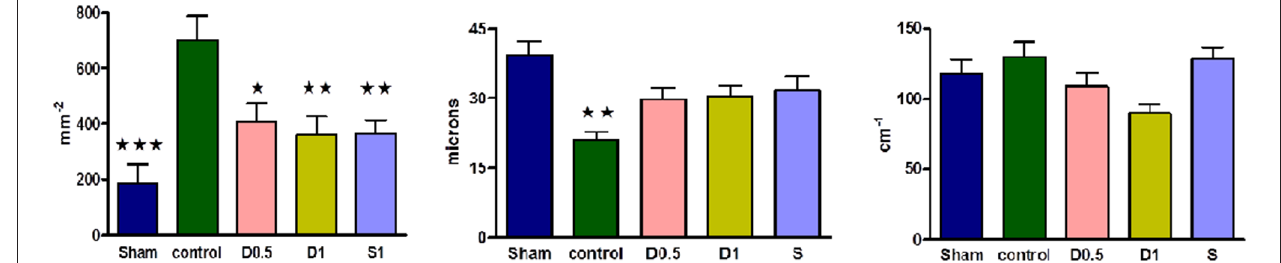
FIGURE 2 | (Left) Numbers of adherent leucocytes per square mm of endothelium in ileal post-capillary venules at 2.5h of laparotomy and endotoxemia ( n = 6 all groups). Numbers of vessels observed per group ranged from 8 to 18. Sham, dopexamine, and salbutamol treated groups demonstrated significantly less adhesion than controls. Data presented as mean (SEM). One-way ANOVA (Bonferroni’s post-tests, * p < 0.05, ** p < 0.01, *** p < 0.001 vs. controls). (Mid) Intestinal arteriolar diameters of the ileum at 2.5h of laparotomy and endotoxemia ( n = 6 all groups). Numbers of vessels measured per group ranged from 8 to 19. When compared to shams and unlike controls, ileal arteriolar diameters were not significantly reduced in dopexamine and salbutamol treated groups. Data presented as mean (SEM). One-way ANOVA (Bonferroni’s post-tests, ** p < 0.01 vs. shams). (Right) Intestinal functional capillary density in longitudinal layers of the ileal muscularis at 2.5h of laparotomy and endotoxemia ( n = 6 all groups). Number of images per group ranged from 16 to 25. Groups were significantly different with respect to longitudinal FCD at 2.5h. Data presented as mean (SEM). One-way ANOVA p = 0.024 (no groups positive in post-tests, although p < 0.01 when comparing control and D1 group with unpaired t -test with Welch’s correction).